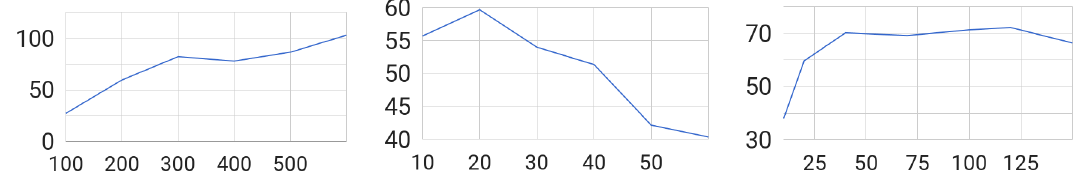
Figure 5. The number of iterations ( y -axis) as